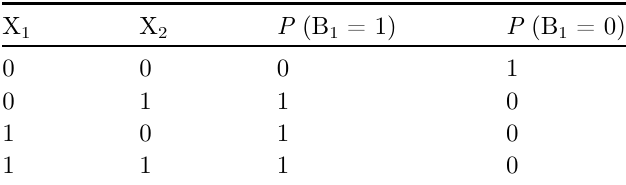
Table 3. Conditional probability of node B